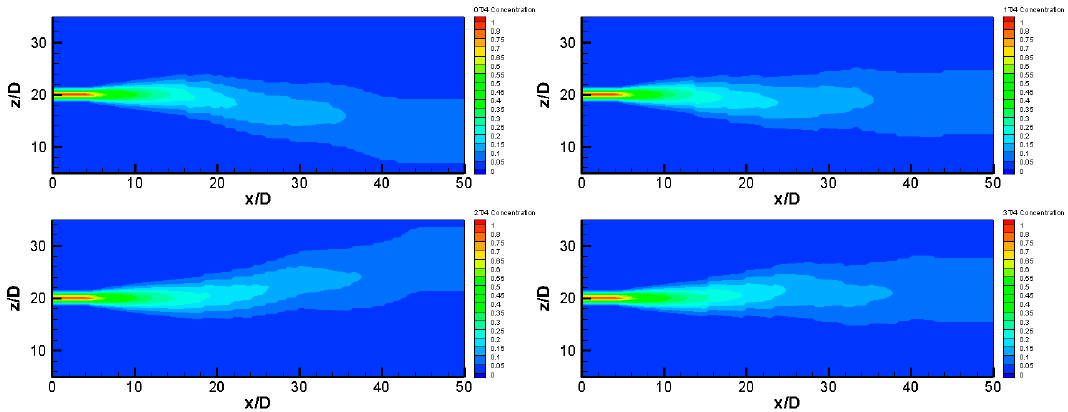
Figure 6. Concentration distributions at different phase moments of the horizontal jet (WC8) in the wave environment.